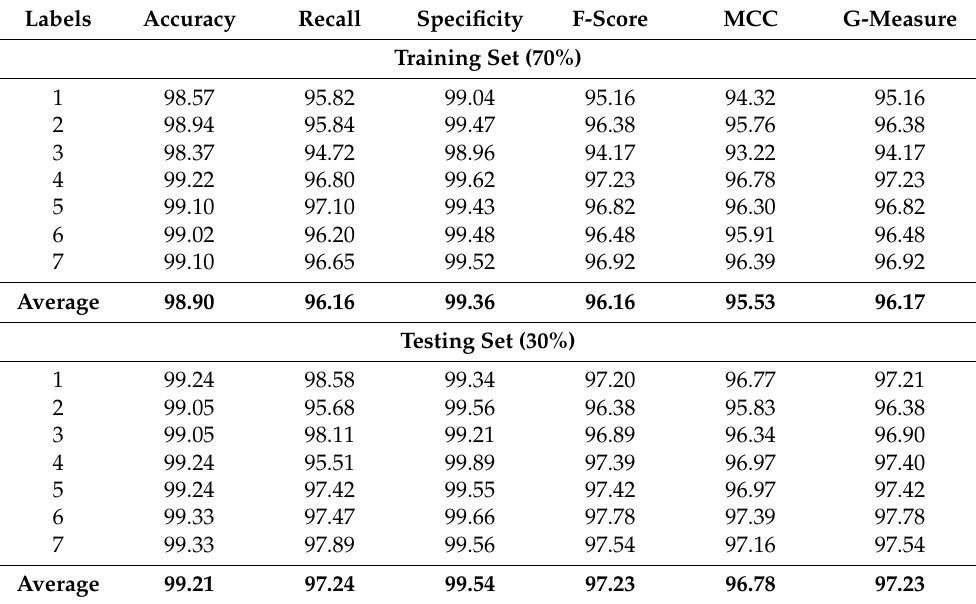
Table 3. Result analysis of CL-DLBIDC approach with distinct measures under 70:30 of the TR/TS data.